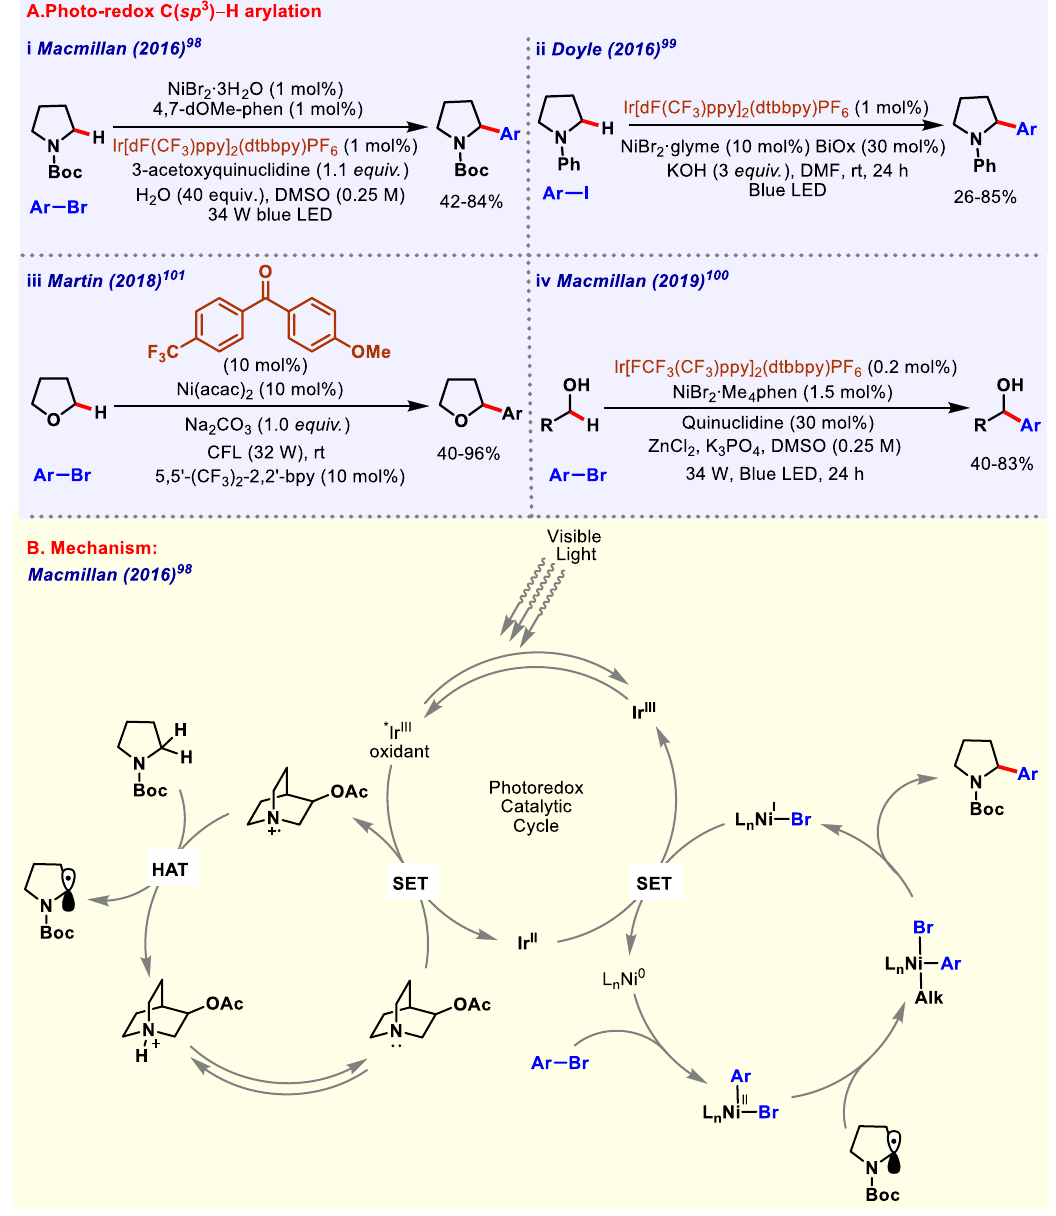
Fig. 7 Photoredox catalyzed C( sp 3 ) – H arylation. A Photoredox C( sp 3 ) – H arylation of arenes and heteroarenes. B Reaction mechanism of Ni/Ir dual catalyzed photoredox